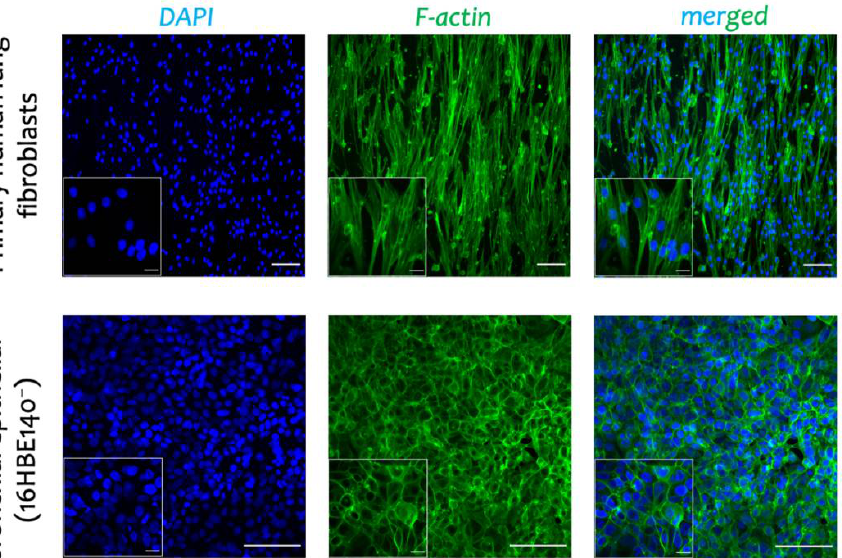
Figure 5. The recellularization of the ECM-integrated BETA scaffold with pulmonary cells. The ECM-integrated BETA scaffolds were repopulated with ( top ) the primary fibroblasts from human (non-CLD donors) and ( bottom ) human bronchial epithelial (16HBE14o − ) cells on the ECM-integrated BETA scaffold. F-actin cytoskeleton (green) and cell nuclei (DAPI, blue). Scale bars in the large and small panels are 20 and 100 µm, respectively.